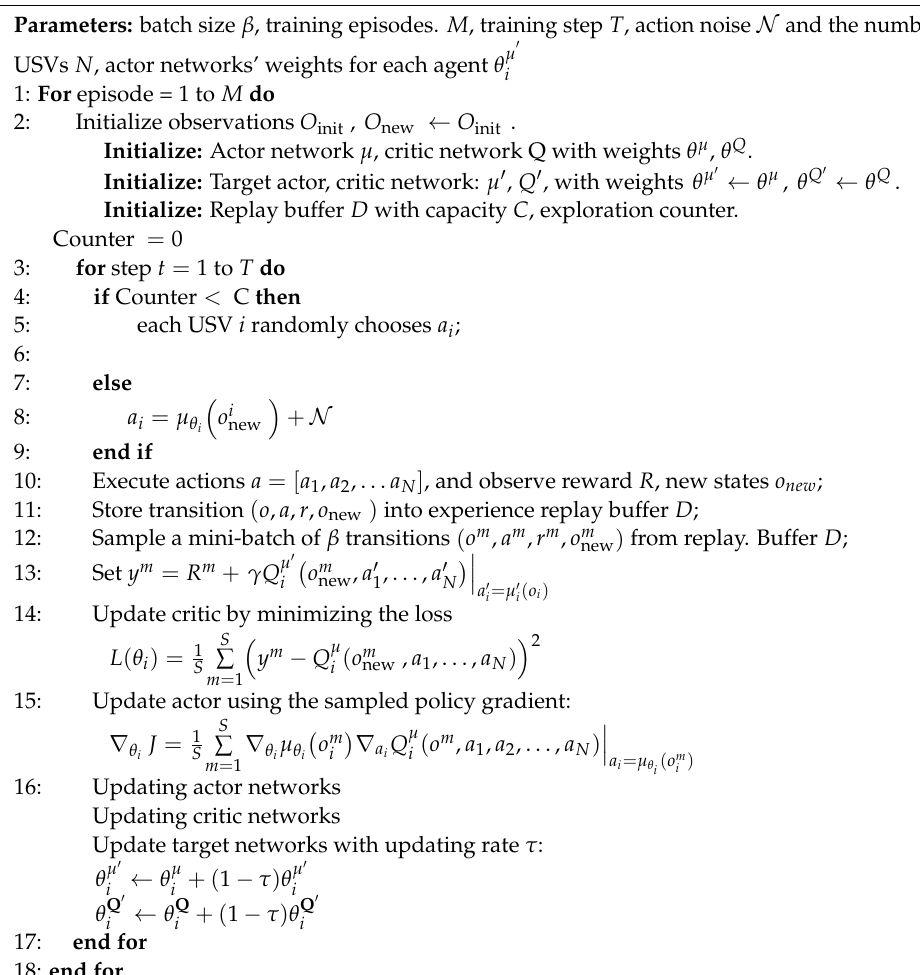
Algorithm 1. Training algorithm using the MADDPG